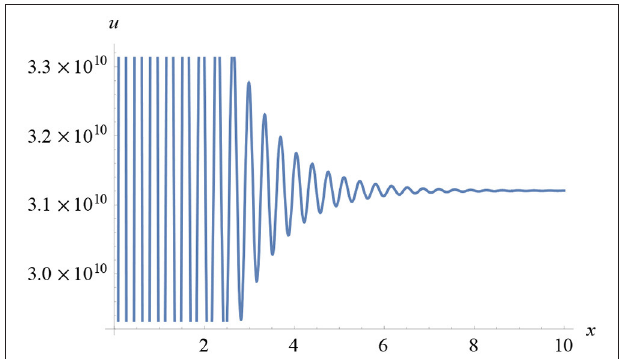
FIGURE 15 | Plot of u ( x ) vs. x illustrating the function’s tendency to approach the limiting value of approximately 3.1 10 10 Pascals, assuming that there is × no loss, nor transfer, of energy into or out of the system, according to the adiabatic